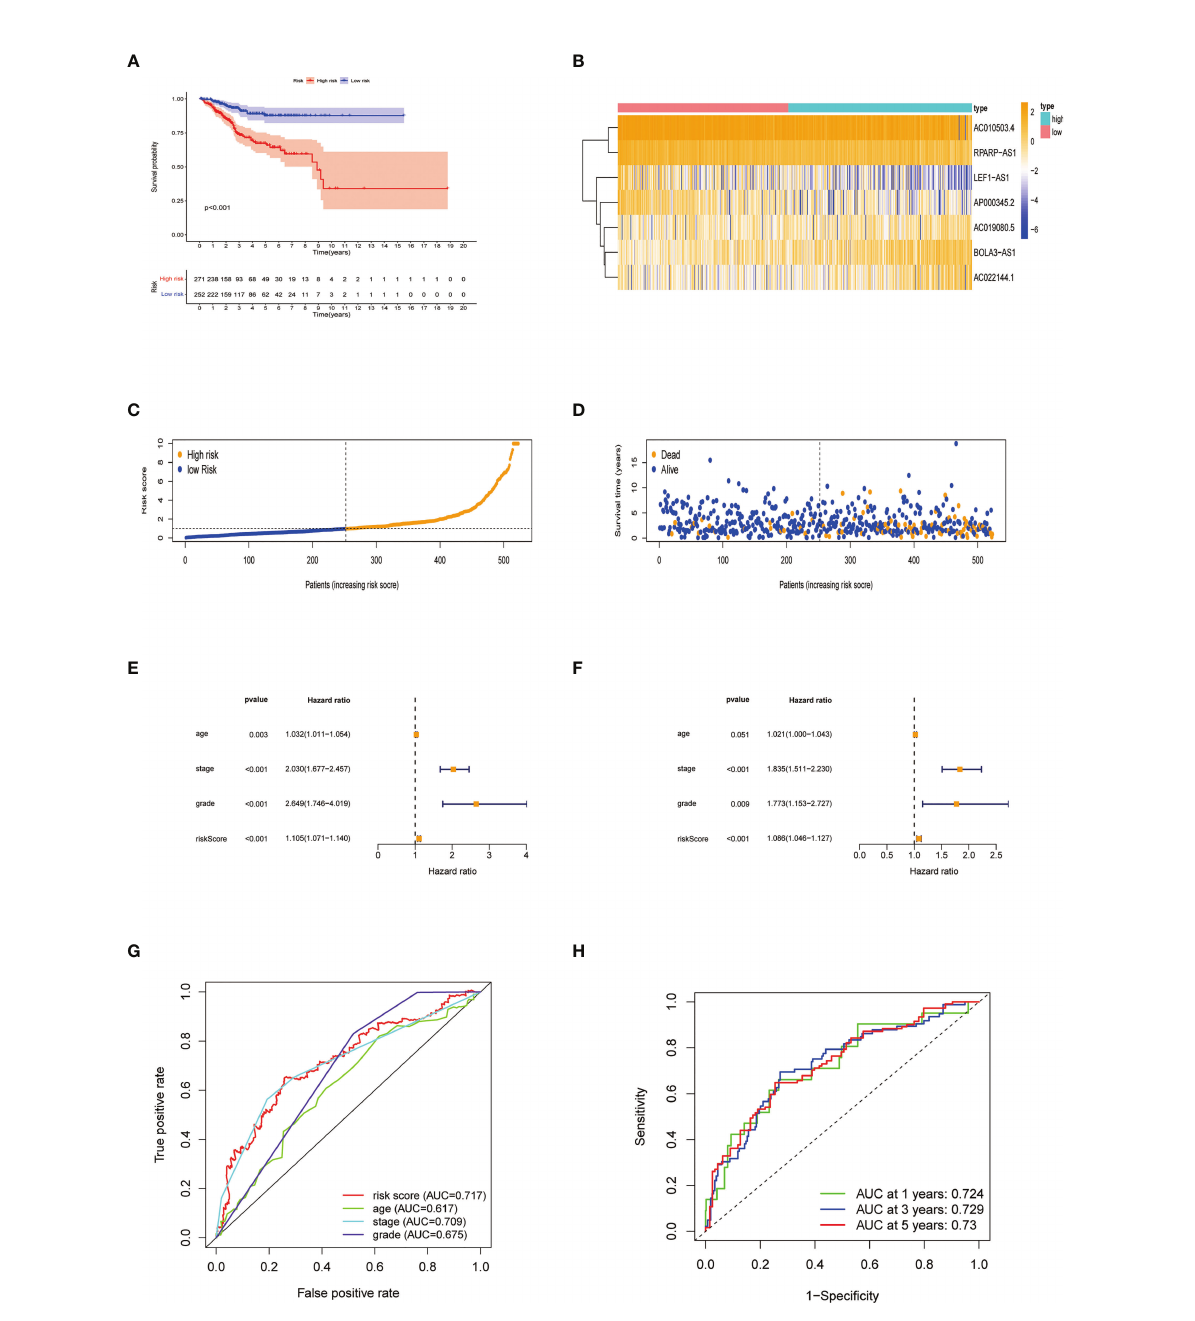
FIGURE 4 Characteristics of the predictive signature. (A) Kaplan-Meier curves for the OS of EC patients in the low- and high-risk groups. (B) Expression pro fi les of 7 necroptosis-related lncRNAs in the low- and high-risk groups. (C) The risk score distribution between these two groups. The black dotted line is the optimal cut-of value for dividing patients into low- and high-risk groups. (D) The distribution of survival status of patients with different risk scores. Blue dots represent the number of survivors, and orange dots represent the number of deaths. (E) Forest plot for univariate Cox regression analysis of clinical factors and risk score with OS. (F) Forest plot for multivariate Cox regression analysis of clinical factors and risk score with OS. The necroptosis-related lncRNAs signature is an independent prognostic factor. (G) The ROC curve of the risk score and other clinicopathological variables. (H) The ROC curve and AUC values at 1-, 3-, and 5-year survival for the predictive